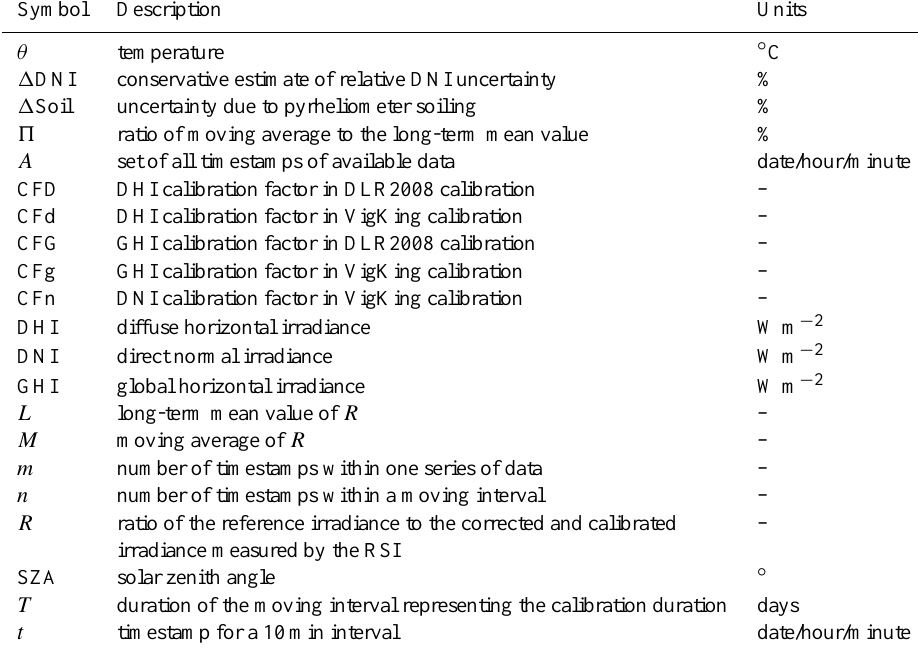
Table 1. Parameter list.